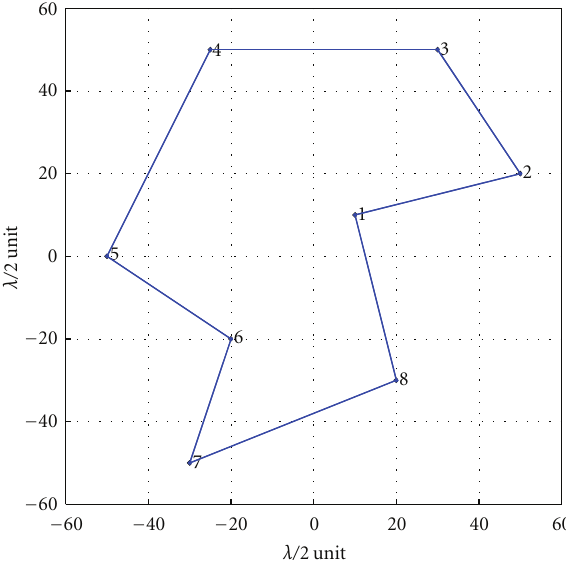
Figure 8: Network